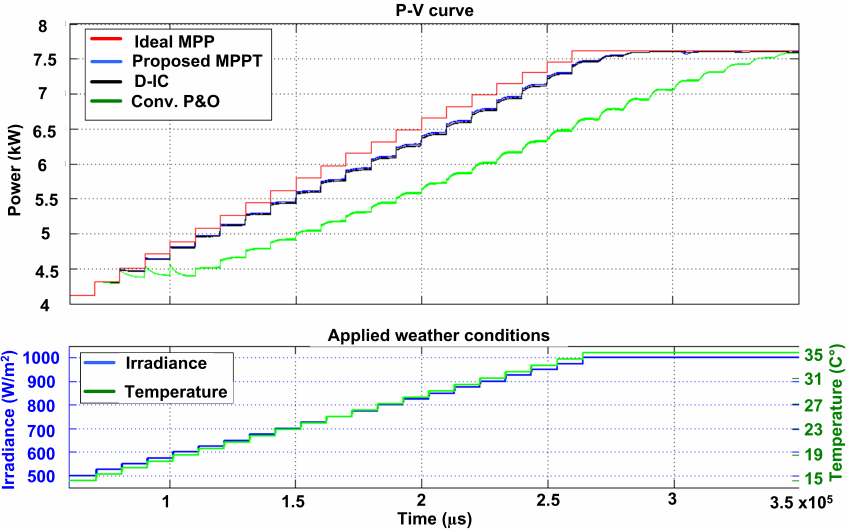
Figure 10. Case 1: Response of three algorithms against step increment in weather